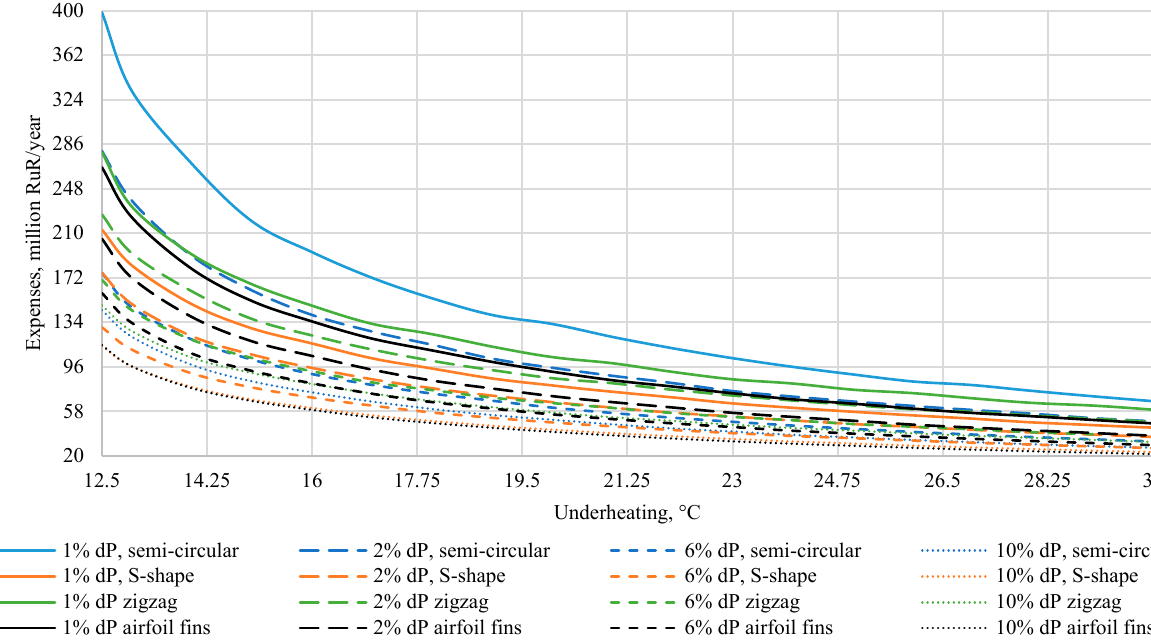
Figure 11. Regenerative system expenses vs. underheating and pressure losses.